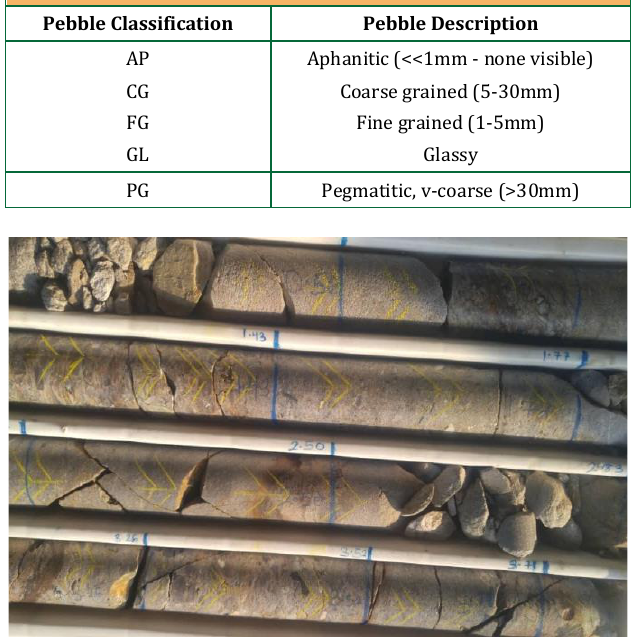
Table 2: Pebble size classification is done using the grain size classification library